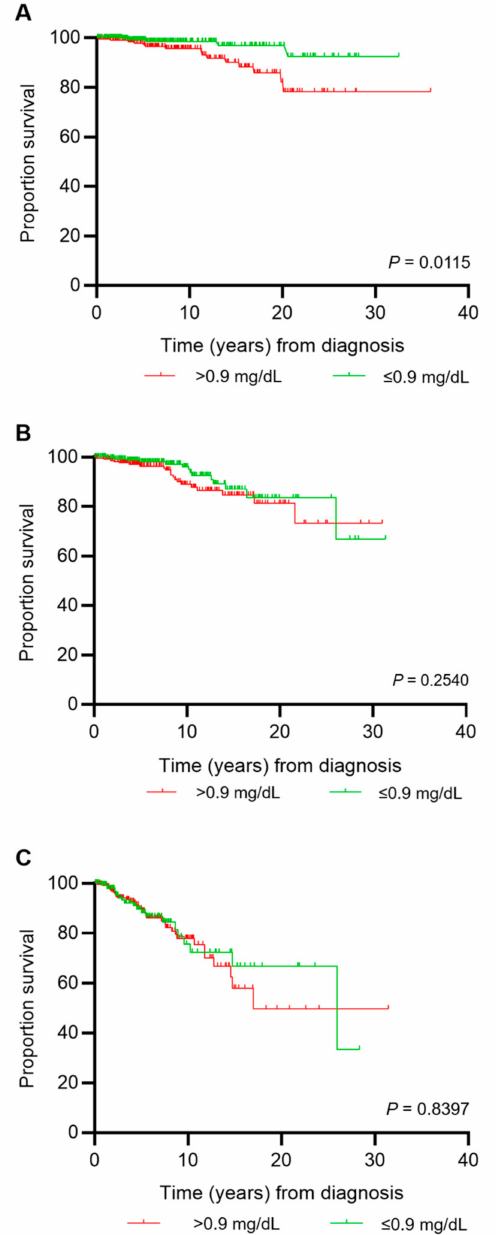
Figure 2. Overall survival according to creatinine level ≤ 0.9 mg/dL (green) or >0.9 mg/dL (red) at entry into the registry. Creatinine rather than eGFR was used for survival analysis, since the eGFR formula contains age as one of the variables. ( A ) Survival analysis for pts with essential thrombocythemia (ET); ( B ) survival analysis for pts with polycythemia vera (PV); ( C ) survival analysis for pts with myelofibrosis (MF), including pts with primary MF, post-PV MF, and post-ET